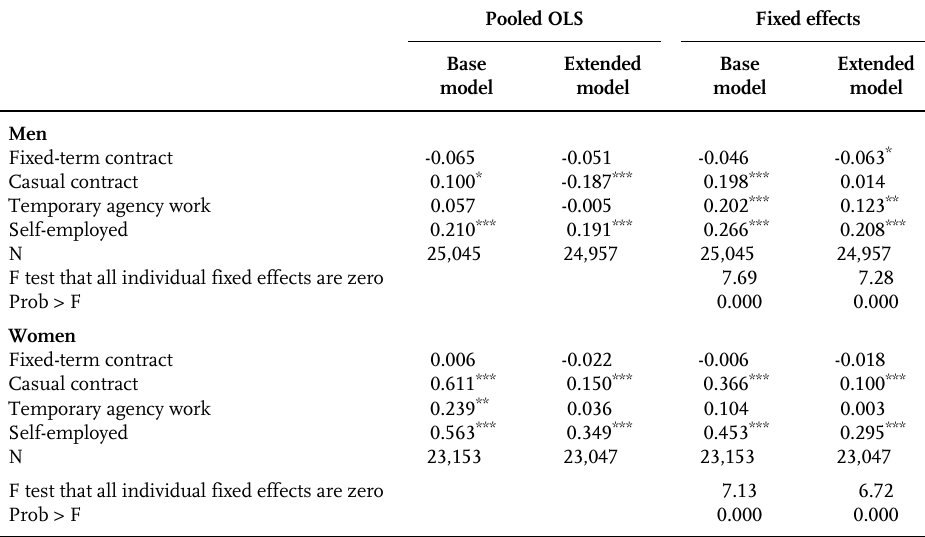
Table 4 : Employment type and WFC (reflected scale) of parents with children aged 17 and younger: Comparison of estimates from pooled OLS and fixed-effects